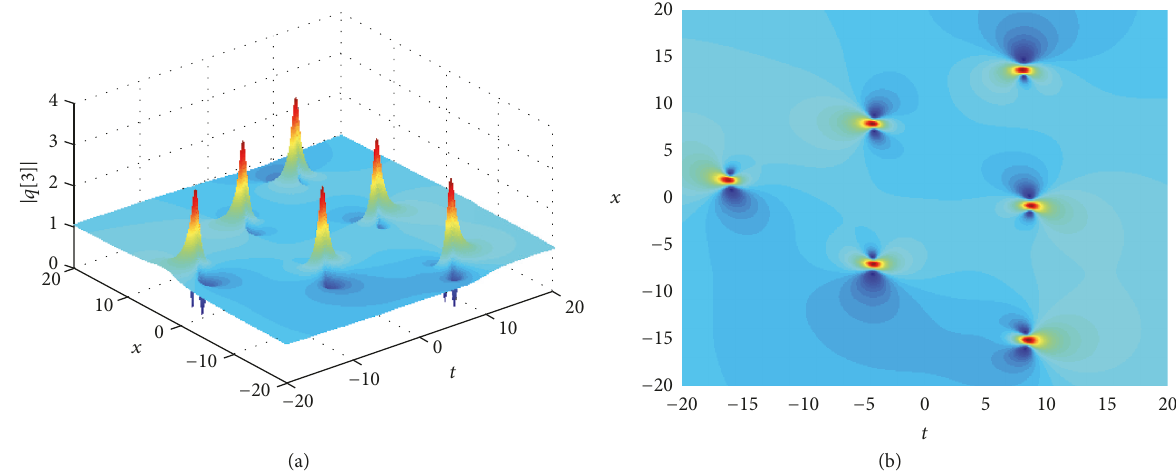
Figure 5: (a) The third-order rogue wave with 𝜀 = 0.02 and 𝑏 1 = 500 ; (b) the density plot with 𝜀 = 0.02 and 𝑏 1 = 500